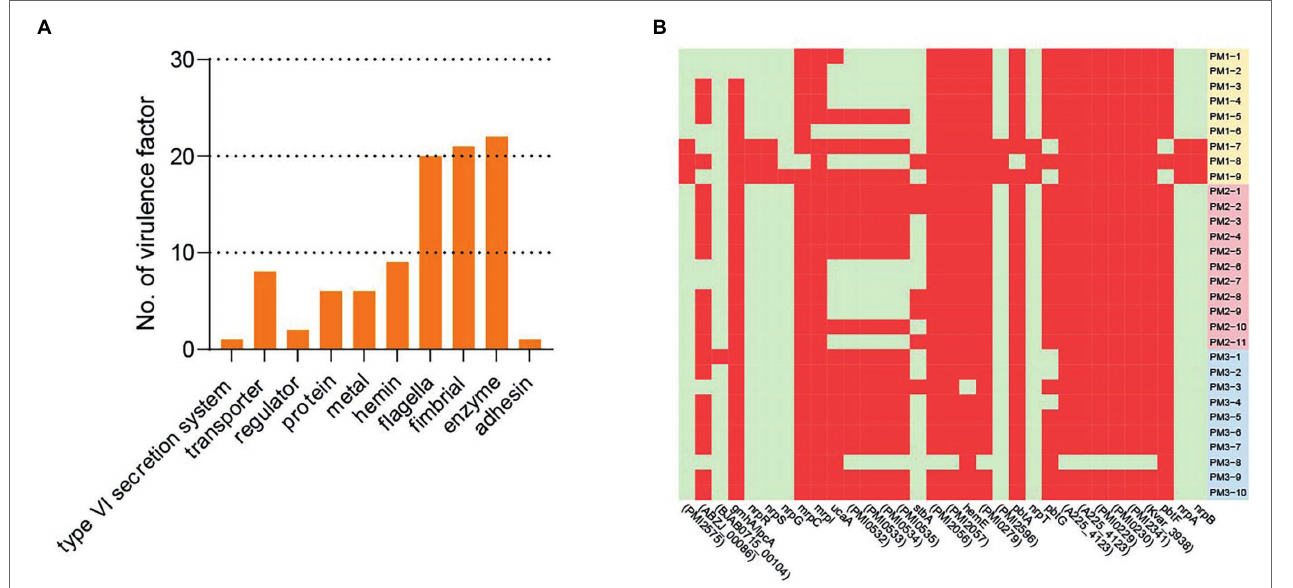
FIGURE 6 | Virulence factors. (A) Virulence factor categories and the number represented in each category. (B) Virulence factors that were variably present among isolates. Red, positive; green,